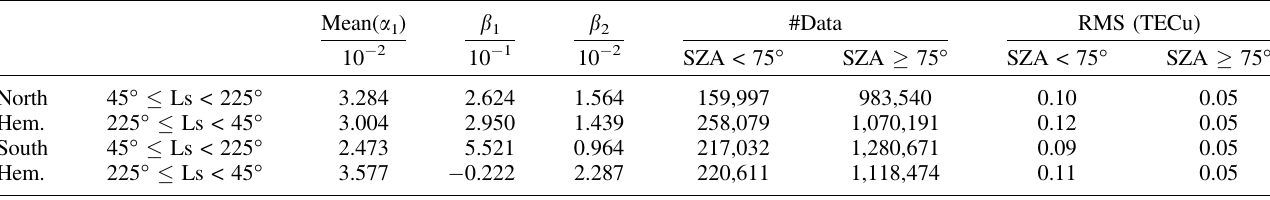
Table 1. Coef fi cients for the MoMo model to predict the vTEC in the Mars ’ ionosphere. These coef fi cients are given for different ranges of solar longitude (Ls) and the two hemispheres. The number of data per range of SZA and the associated RMS of the differences between the vTEC predicted by the model and the observed vTEC are reported in the last columns.